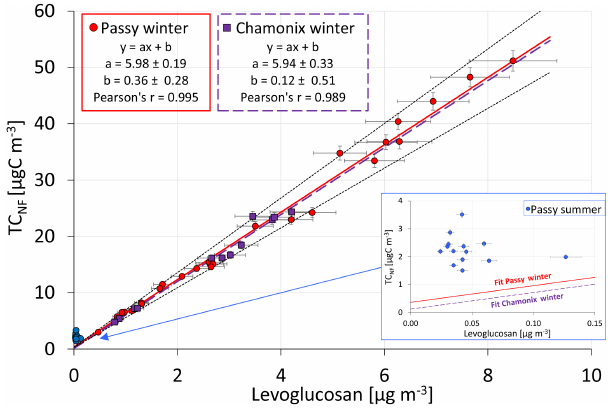
Figure 7. Comparison of TC NF , based on 14 C / 12 C ratio measure- ments, with levoglucosan. TC NF corresponds to the carbon concen- tration multiplied by the f NF . For the winter samples, f NF is de- termined for p bio = 0 and for summer samples, p bio = 1. It has to be underlined that a variation in p bio does not affect the signifi- cance of the relationship between levoglucosan and TC NF (see Ta- ble 5). Purple squares indicate Chamonix winter samples, red dots Passy winter samples, and blue dots denote Passy summer samples. Winter samples display very strong correlations between TC NF and levoglucosan with close to zero intercepts, suggesting that virtually all of the TC NF originates from biomass burning. The fit parame- ters have been calculated by taking into account both error bars on the x and y axes and are given with their 95% confidence interval. Black dotted lines stand for two extreme cases assuming only young air (i.e., SOA = 25% of POA) or only older air (i.e., SOA = 50% of POA); see Sect. 3.2.1 for further information. No correlation is found for the summer samples, implying the summer TC NF origi- nates from other non-fossil sources.